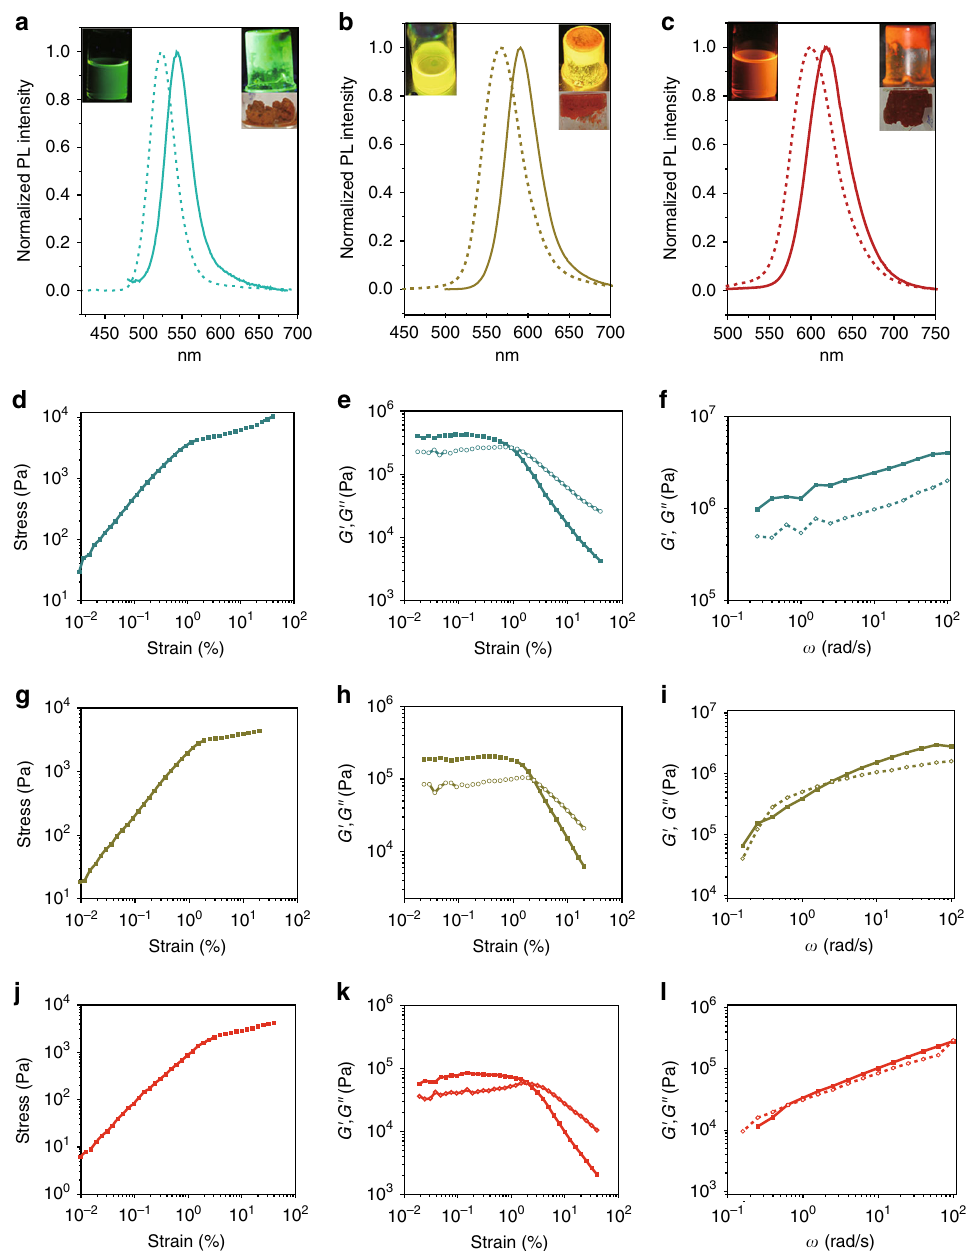
Fig. 1 Optical and mechanical characterization of hydrogels. Optical images and fl uorescence spectra of CdTe NP solutions (dashed line) and hydrogels (solid line), Hydrogel-544 ( a ), Hydrogel-590 ( b ), and Hydrogel-618 ( c ). Measurement of oscillatory stress/strain of Hydrogel-544 ( d ), Hydrogel-590 ( g ), and Hydrogel-618 ( j ). Measurement of continuous step moduli/strain of Hydrogel-544 ( e ), Hydrogel-590 ( h ), and Hydrogel-618 ( k ). Each measurement was performed at least twice on two different disc specimens from the same sample. Rheological dynamic oscillatory frequency sweep tests of Hydrogel- 544 ( f ), Hydrogel-590 ( i ), and Hydrogel-618 ( l ). The solid data point and dark color lines in e , f , h , i , k , and l correspond to the storage moduli G ′ ( ω ), which is associated with gel elasticity (stiffness). The open data point and light color lines in e , f , h , i , k , and l correspond to the loss moduli G ″ ( ω ), which describes energy dissipation in the gel. The shear dynamics for each NP gel was measured from low to high-strain starting at 0.01 – 20 % at a frequency of 1 Hz or 6.28 rad/s. The rheological dynamic oscillatory frequency sweep measurements were performed with a parallel fi xed plate geometry (diameter 25 mm) at a strain value of 0.01